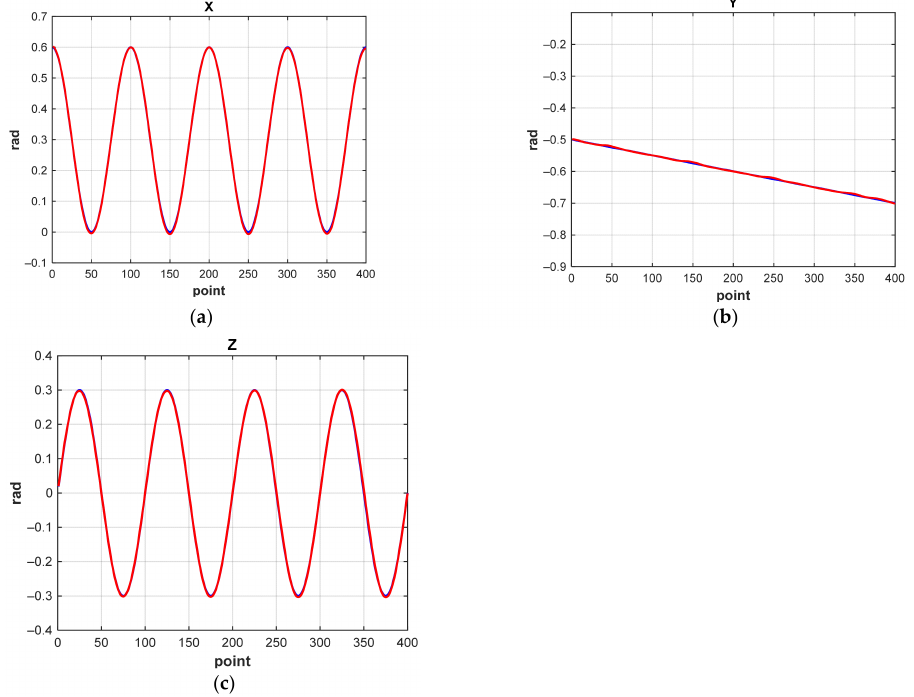
Figure 20. Graphs of coordinate changes during the movement of the manipulator in a spiral in 3D (the correctional NN): ( a ) along the X-axis; ( b ) along the Y-axis; ( c ) along the